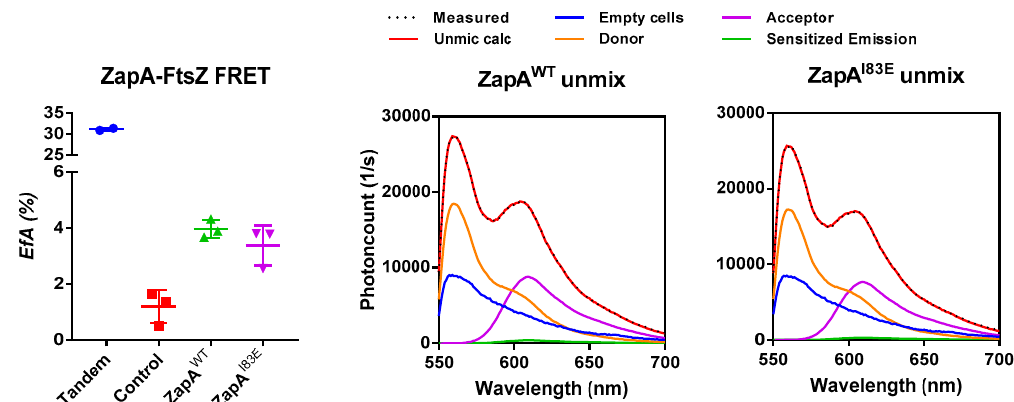
Figure 3. FtsZ and ZapA I83E in vivo interaction FRET assay. On the left, the energy transfer efficiency of the FRET interactions indicated in the text. The positive and negative controls suggest a reliable experiment. On the right, typical emission spectra plotted against the photoncounts for the mCh–ZapA and mKO–FtsZ pairs. The contribution of the direct excitation of mCh (purple), mKO (orange), and the background autofluorescence (blue) to the measured spectrum (dotted line) were obtained by spectral unmixing [19,20].